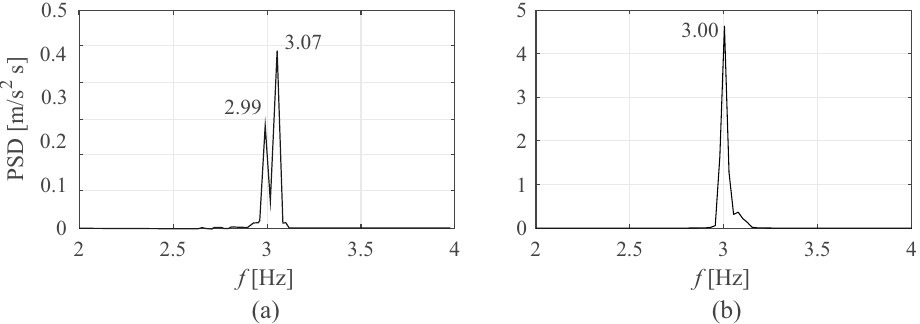
Figure 15. Comparison between PSD of experimental (after [20]) ( a ) and numerical ( b ) verti- cal